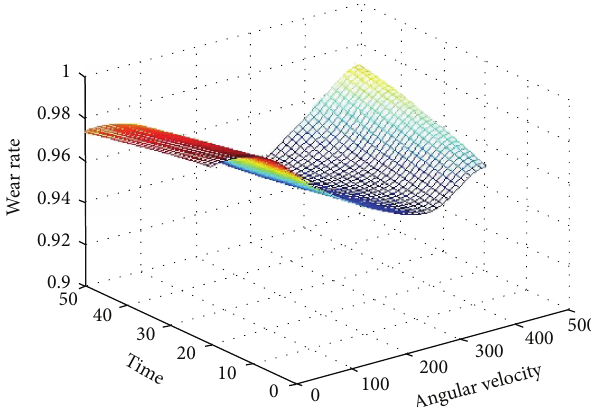
Figure 4: Schematic diagram of the time-varying wear model.